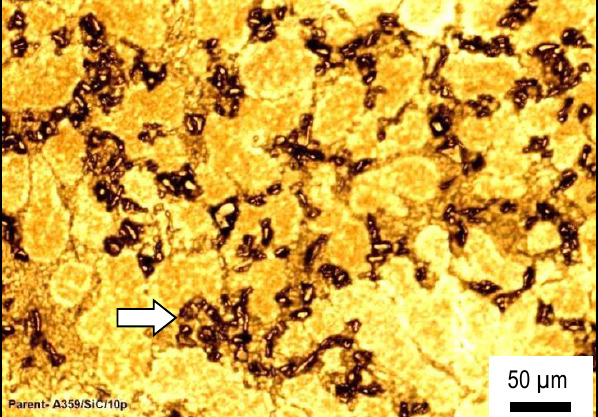
Figure 7: Microstructure of as-cast A359/SiC/10p. The typical SiC particles (at arrow) are in eutectic zone of the cast MMC.